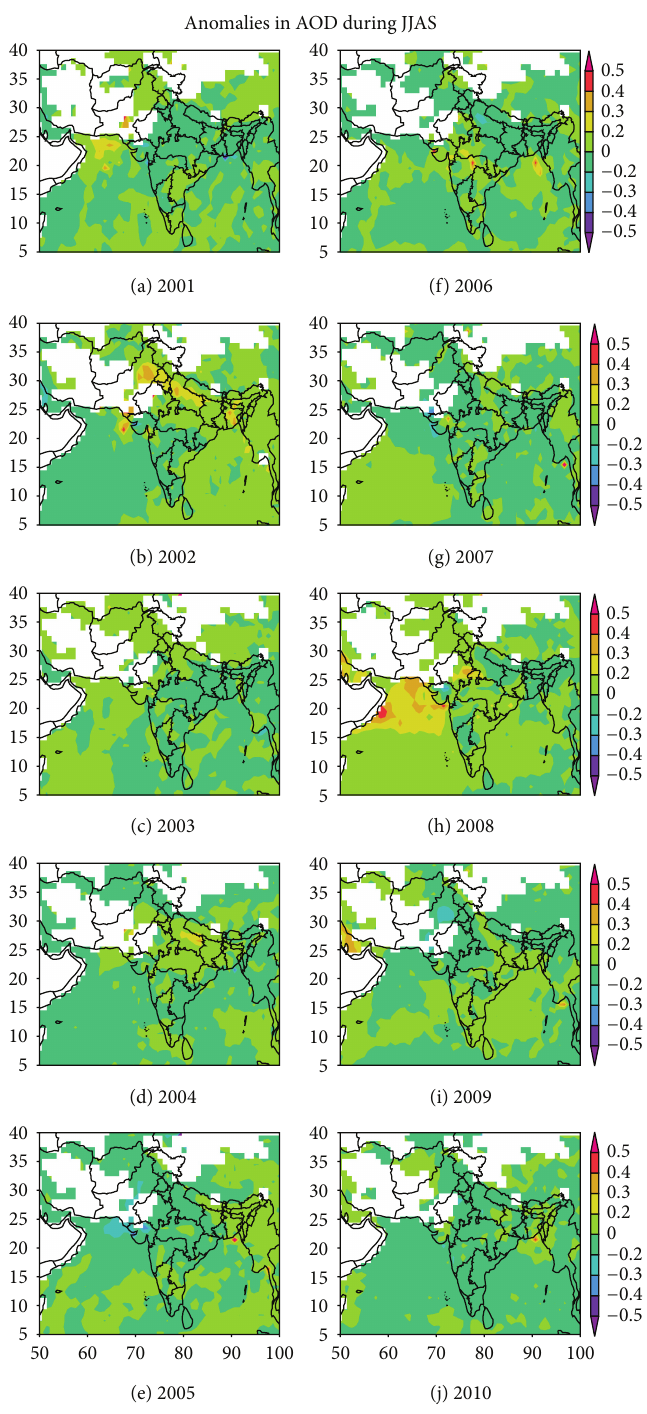
Figure 6: Anomalies in aerosol optical depth (AOD) during the southwest monsoon season (JJAS) in (a) 2001, (b) 2002, (c) 2003, (d) 2004, (e) 2005, (f) 2006, (g) 2007, (h) 2008, (i) 2009, and (j) 2010 over the Arabian Sea, India, and the Bay of Bengal.